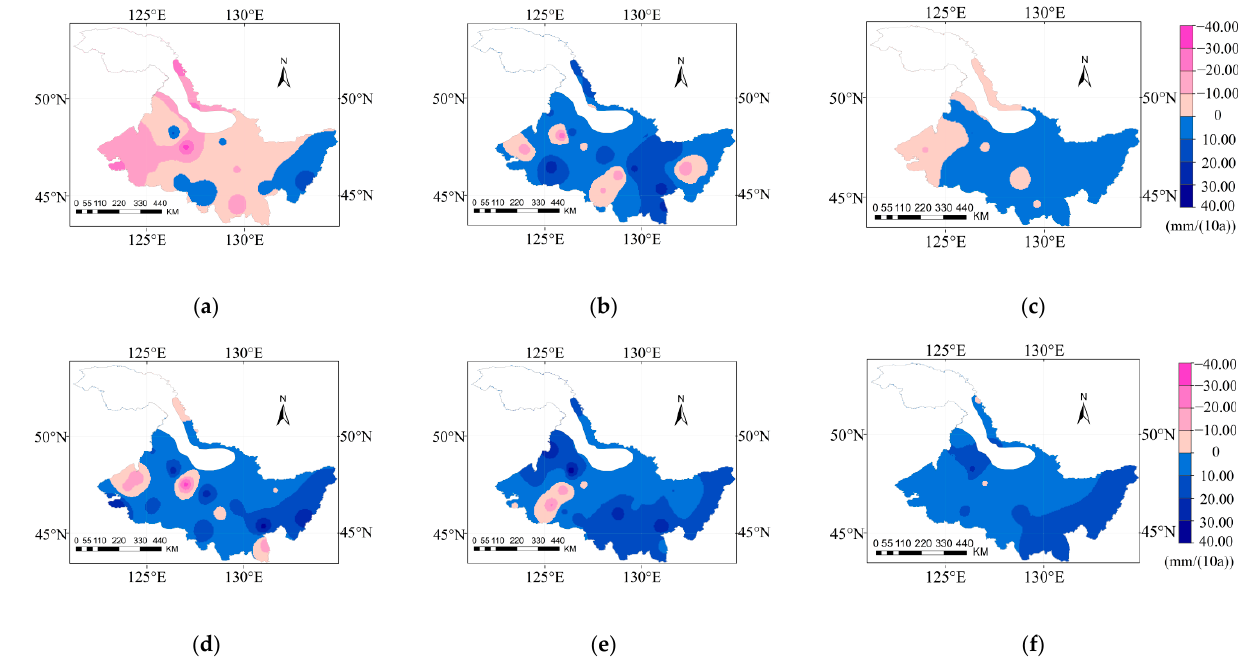
Figure 8. Spatial distribution of effective precipitation ( P e ) during the ( a ) 2030s, ( b ) 2050s, and ( c ) 2070s under RCP4.5, and during the ( d ) 2030s, ( e ) 2050s, and ( f ) 2070s under RCP8.5 during the soybean growth period.